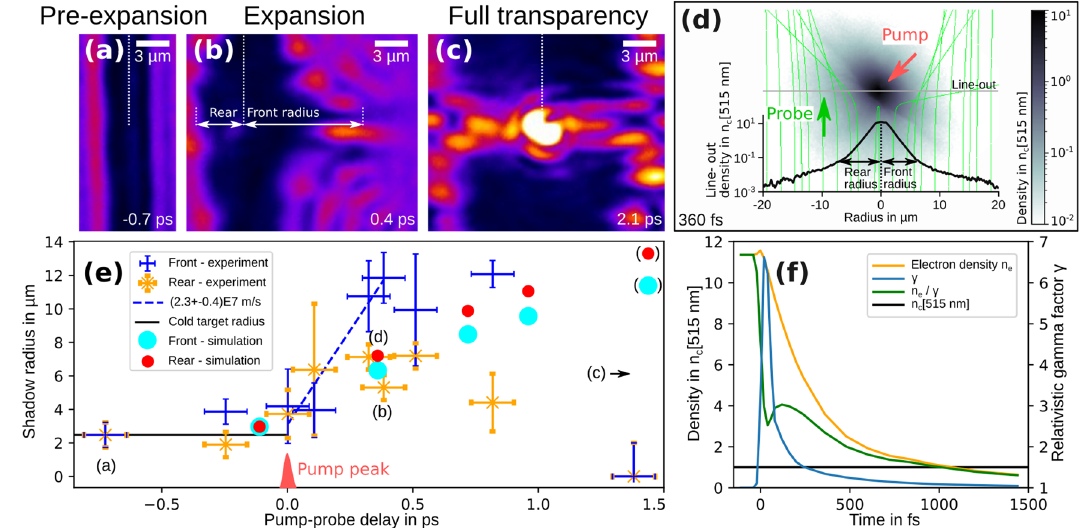
Figure 4. Close up of three shadowgraphy images, each representative for three characteristic transient target states: (a) target ionization and pre-expansion by the pump laser rising edge; (b) rapid plasma expansion after the pump laser peak; (c) full transparency of the target after single picoseconds. The color scale is consistent in all images. (d) Ray tracing of the PIC-simulation results: Top view slice of the density n e /γ at 360 fs after the pump laser peak is shown in gray color scale. The refractive index is calculated by formula 1 and inserted into the object plane of an imaging setup in Zemax with similar imaging properties like the experimental setup. The bending of the probe rays in the object plane is visualized by the green lines. The simulated front and rear side shadow radius are retrieved in the image plane and presented together with a horizontal line-out of the density. The spatial scale of the line-out and the top view slice is equivalent. (e) Evolution of the shadow radii for different pump-probe delays in the experiment (crosses) and ray tracing of the PIC simulation result (circles, brackets indicate the occurrence of transmitted light within the shadow). (f) Temporal evolution of n e , γ and n e /γ from the PIC simulation averaged over the initial target bulk ( 2.5 µ m radius and 1 µ m along the target